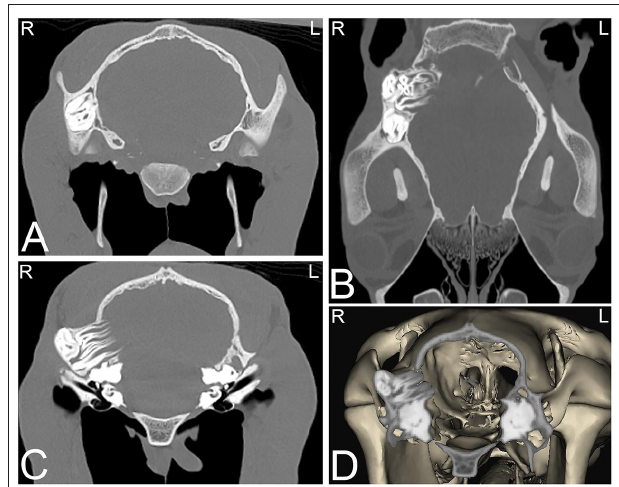
FIGURE 6 | Chronic mandibular fracture with cheek tooth apical infection. Radiographic and CT images of a chronic fracture of the right mandible with involvement of the right mandibular premolar teeth in an 8-year-old Miniature horse. Right dorsal to left ventral oblique radiograph (A) , transverse (B) , dorsal (C) and sagittal (D) CT images of the rostral aspect of the head displayed in a bone window reveal a chronic right mandibular fracture ( A,C,D , white arrows) with moderate osseous remodeling and involvement of the right second mandibular premolar tooth (Triadan 406). Gas is noted in the pulp of Triadan 406 ( B , black arrow). Actinomyces species were cultured from tooth after its extraction. L, left; R, right.